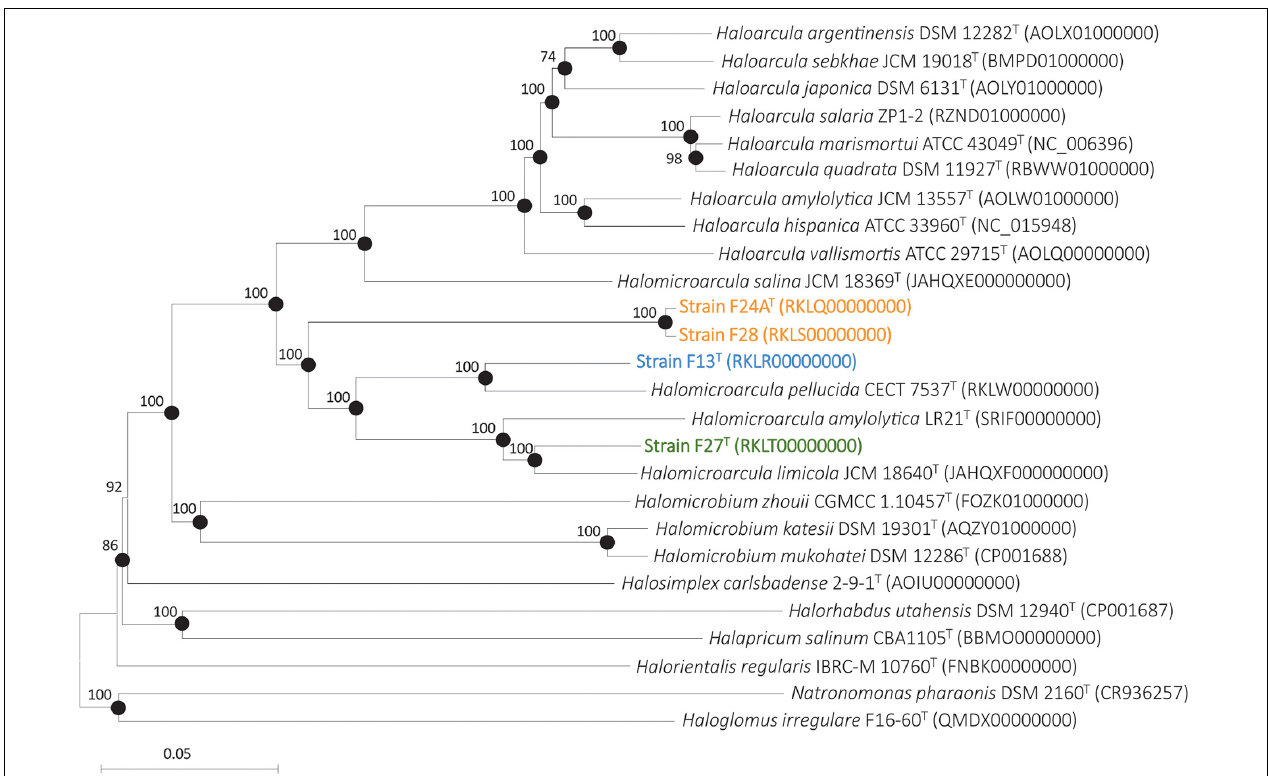
FIGURE 1 | Neighbor-joining phylogenomic tree based on the concatenation of 100 orthologous single-copy genes shared by strains F13 T , F24A T , F27 T , F28, members of the genus Halomicroarcula and other related genera. Filled circles indicate branches that were also supported by the maximum-likelihood algorithm. Sequence accession number are shown in parentheses. Bootstrap values ≥ 70% are shown at branch points. Bar, 0.05 changes per nucleotide position.